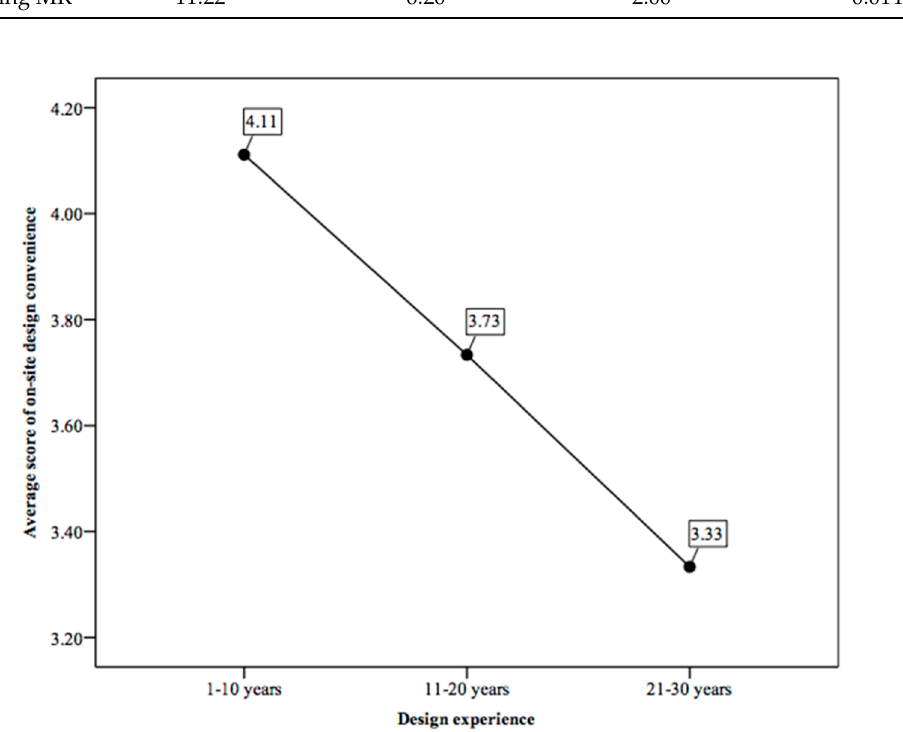
Figure 15. The average scores for on-site design convenience using MR in different design experience groups. Table 6. The Kruskal–Wallis test for different MR usage experience groups in on-site design convenience using MR. Mean Ranks of Scores for the MR Usage Experience Groups